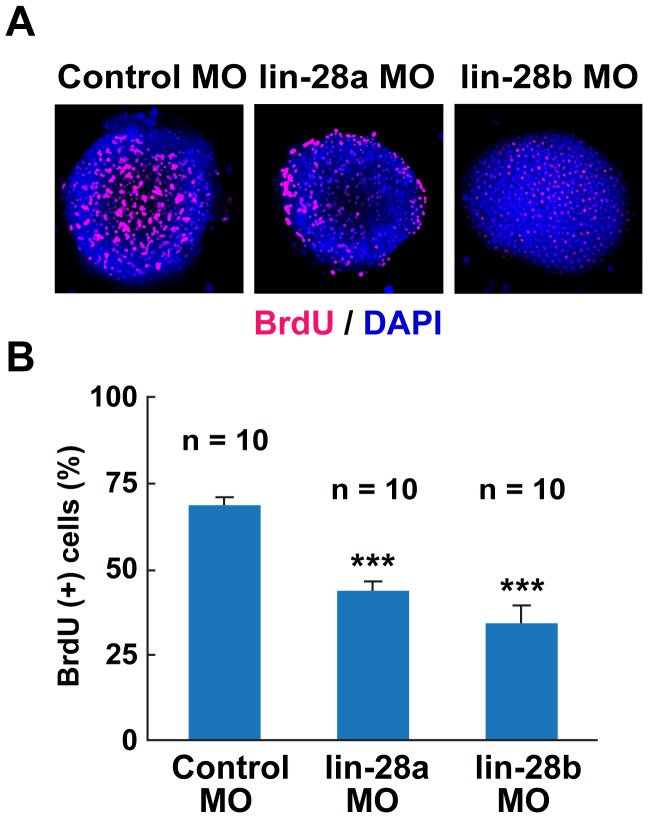
Effect of lin-28a and lin-28b knockdown on cell proliferation.A. Confocal images of BrdU (Red) incorporation in lin-28a and lin-28b morphant embryos at 5hpf. Both lin-28a and lin-28b MO-injected embryos were exposed to BrdU at 4 hpf for 1 hour. The nuclei were stained with DAPI (blue). B. Percentage of BrdU incorporated cells in lin-28a and lin-28b morphants embryos. The percentage of BrdU-incorporated cells was calculated by dividing the number of BrdU-positive cells by the total number of cells as determined by DAPI-stained cells. The percentage of BrdU-positive cells was significantly lower in both lin-28a MO- and lin-28b MO-injected embryos compared with control MO-injected embryos (***p<0.001, control MO vs. lin-28a MO, control MO vs. lin-28b MO, two-tailed test, n = 10, mean ± SEM).